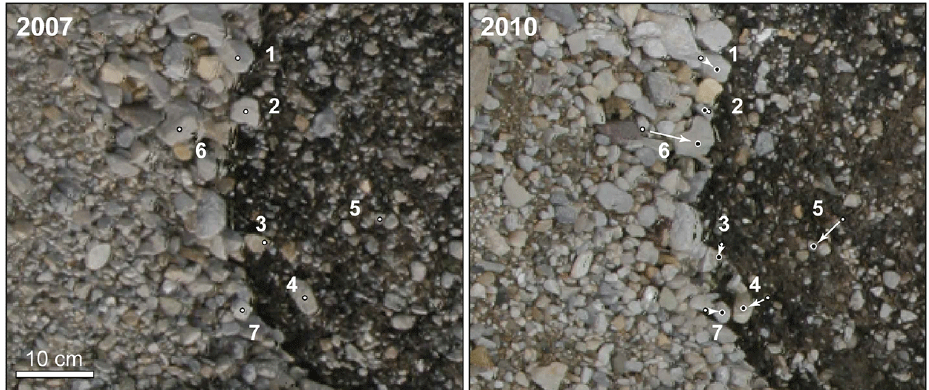
Figure 10. Section of orthoimages for years 2007 and 2010 in the southwestern part of the northern circle. See Fig. 5 for location. Positions of selected stones in 2007 are marked by white dots (left and right), and positions of the corresponding stones in 2010 by black dots (right). Stones 1–3 are in the process of being incorporated into the base of the gravel rings. Stones 4 and 5 move outwards from the circle centre. Stones 6 and 7 fall or slide down the gravel ring. See Supplement for an animated GIF of the 2007 and 2010 orthoimages of the